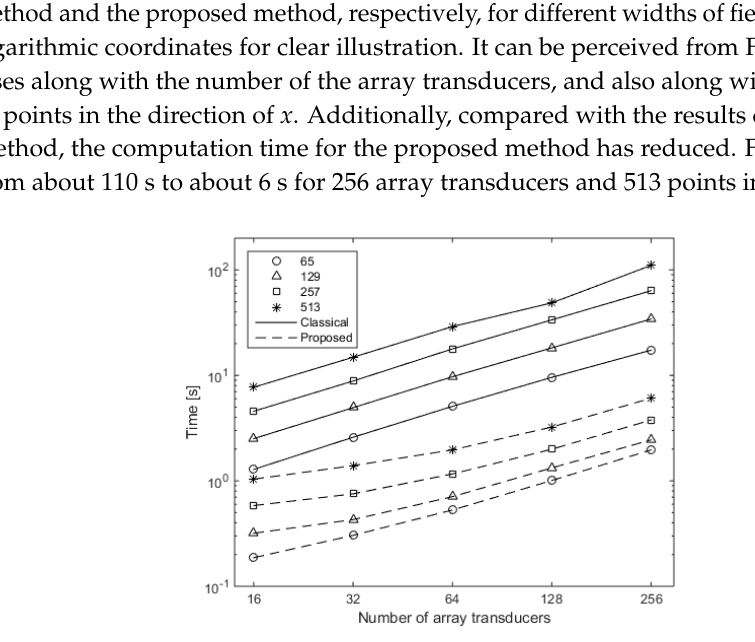
Figure 8. Time cost for the calculation of spatial impulse responses for different transducer numbers with different field widths, using the classical method (solid lines) and the proposed method (dashed lines).